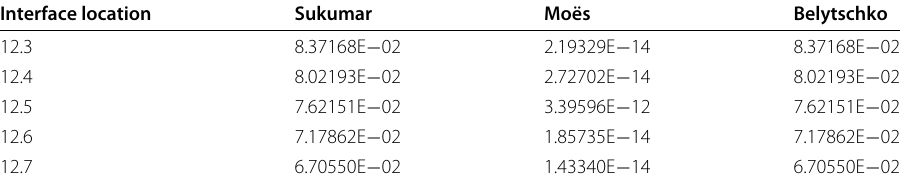
Table 7 Comparison of relative error in energy norm for different interface locations between the different enrichment functions for quadratic elements used in the bi-material bar problem (results obtained with E1 = 2.05 MPa, E2 = 20.5 MPa, L = 25 m and ¯ u = 3 · 10 − 6 m)